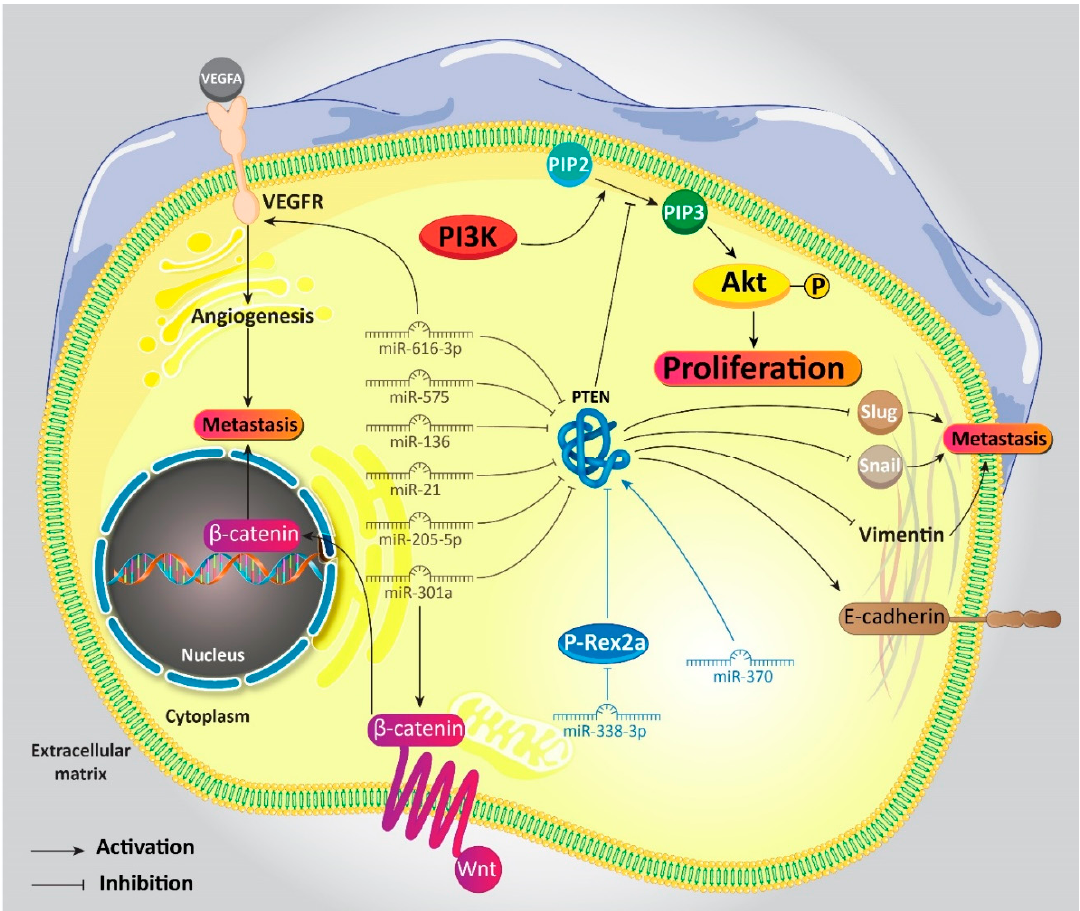
Figure 2. Activation / inactivation of PTEN in gastric cancer and its involvement in proliferation and metastasis of these malignant cells.